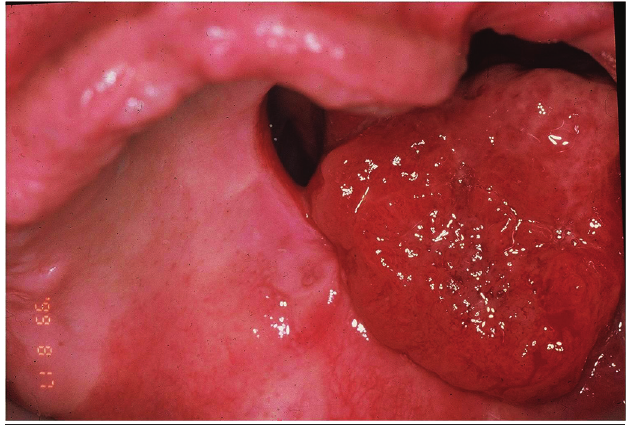
figurE 7 − Recurrence after treatment